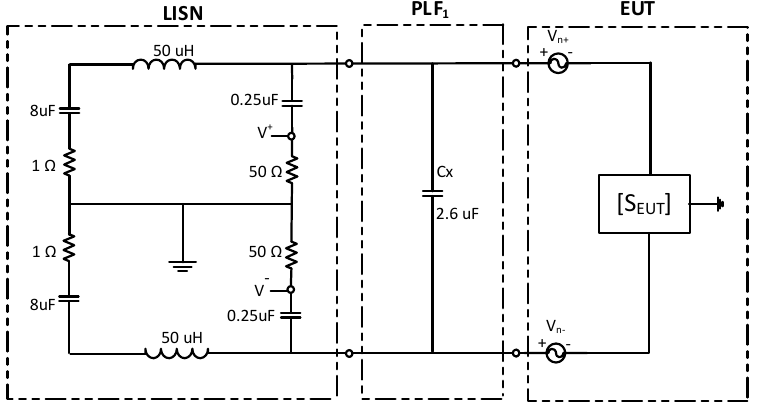
Figure 16. PLF connected between the EUT and the LISN consisting of only an X-type capacitor.